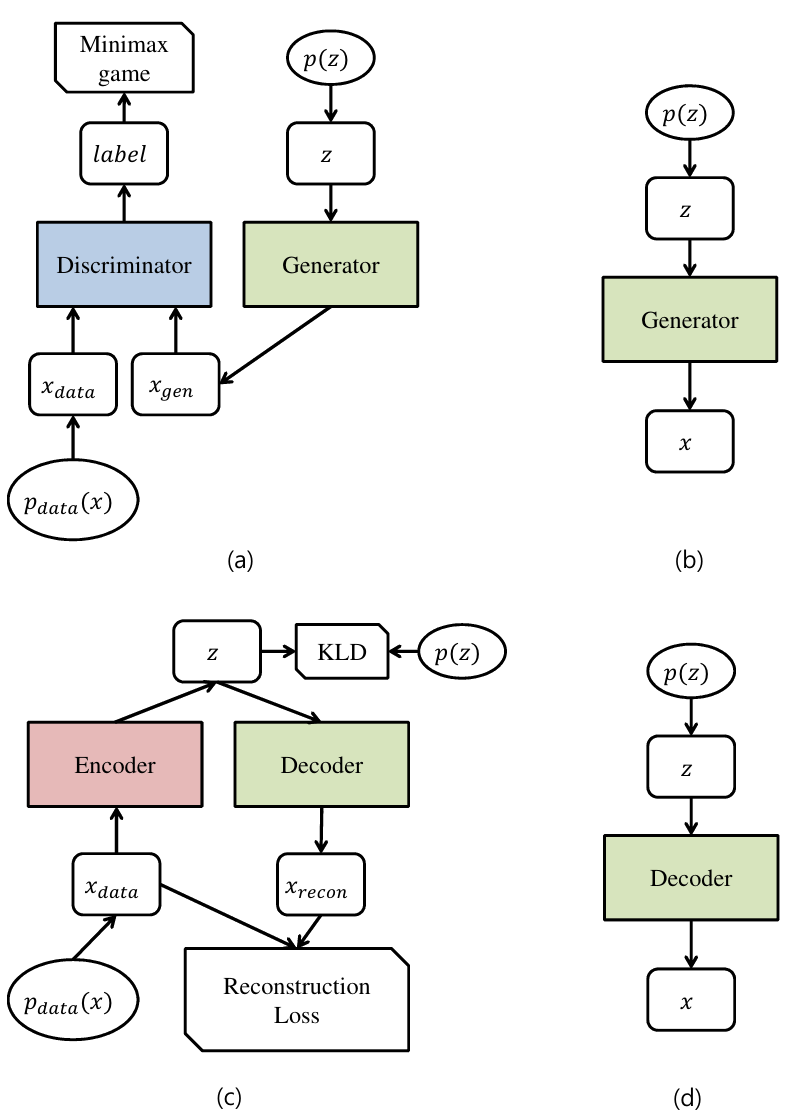
Figure 2. Architectures of GAN and VAE, and their inference parts. ( a ) architecture of GAN; ( b ) inference part of GAN; ( c ) architecture of VAE; ( d ) inference part of